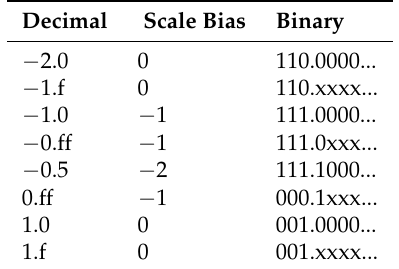
Table 3. The calculation information of the mantissa of the